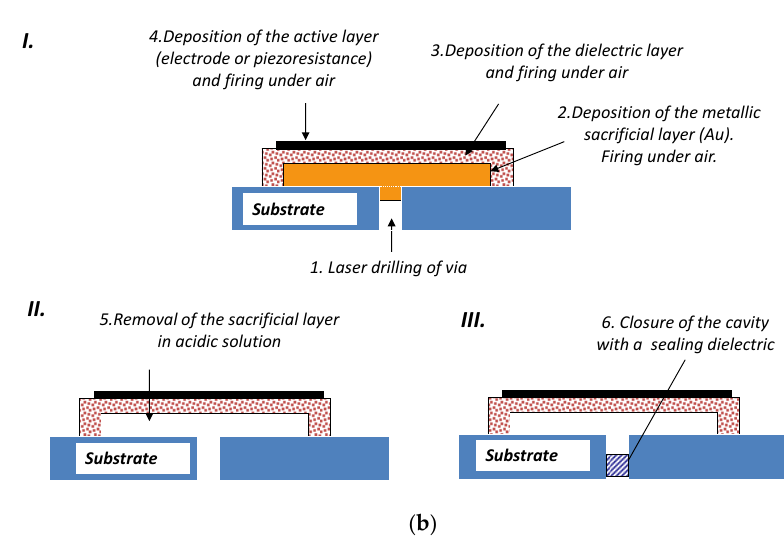
Figure 2. Example of manufacturing steps of thick-film ceramic MEMS pressure sensors using two sacrificial layer compositions: ( a ) Epoxy + carbon and ( b ) gold (inspired respectively from [8] and [26]).